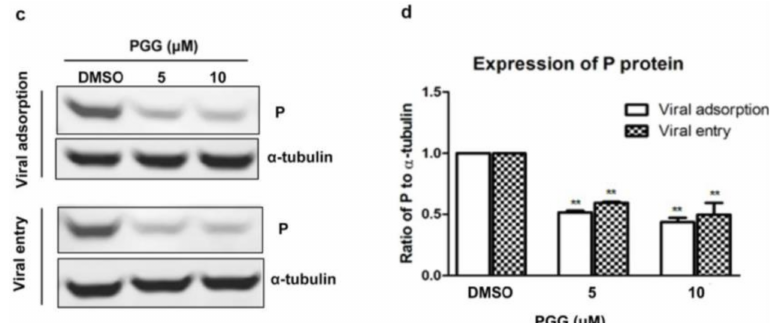
Figure 4. PGG inhibits RABV adsorption and entry. For viral adsorption or entry assay, BHK-21 cells were treated with PGG for 1 h. ( a ) The vira1 P gene mRNA expression level was detected by qRT-PCR; ( b ) The virus titers of culture supernatants were determined by TCID 50 assay and plotted; ( c ) The expression level of viral P protein was analyzed by Western blotting; ( d ) The relative expression levels of viral P, normalizing to that of α -tubulin. (** p < 0.01).